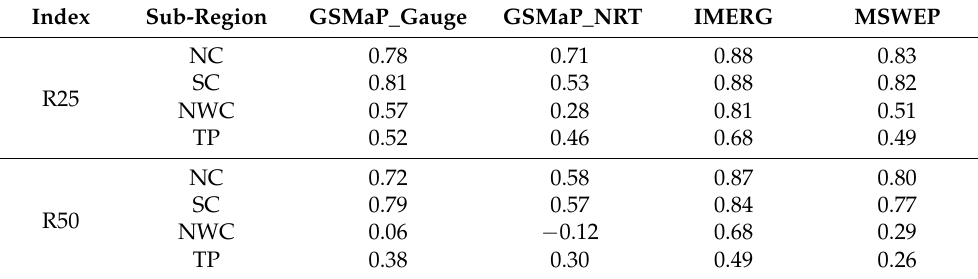
Table 6. The global BMI of frequency indices in four